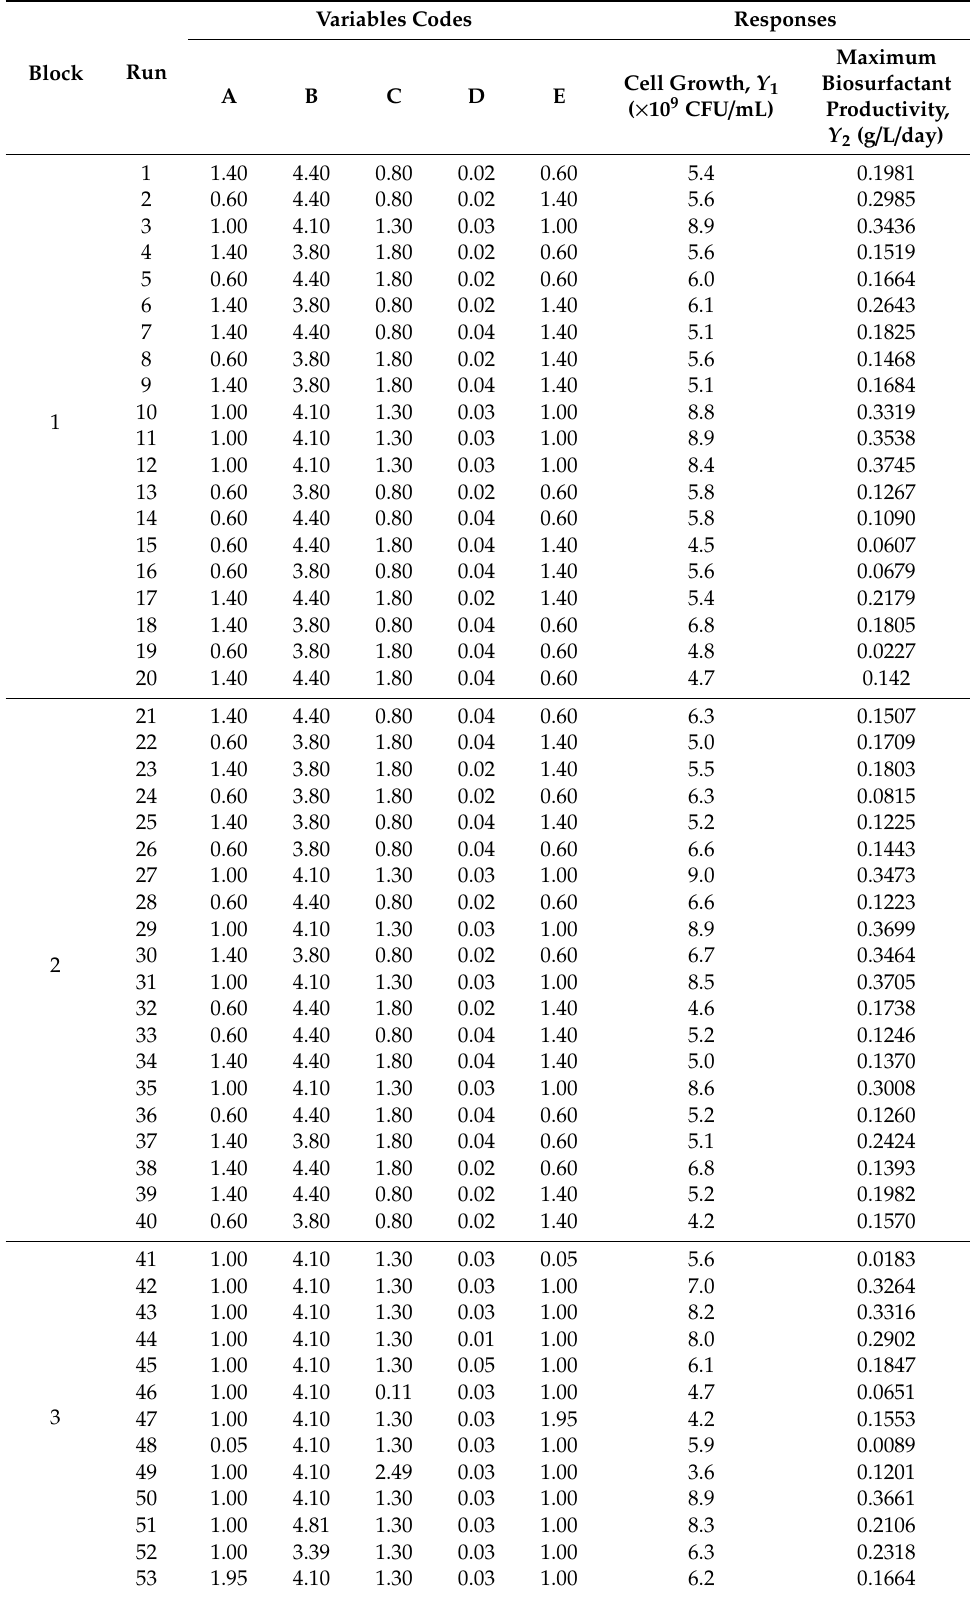
Table 4. Actual factor levels corresponding to coded factor levels for the CCD of the experimental response surface optimization showing cell growth and maximum biosurfactant productivity. Variables Codes Responses Maximum Block Run Cell Growth, Y 1 Biosurfactant ( × 10 9 CFU / mL)